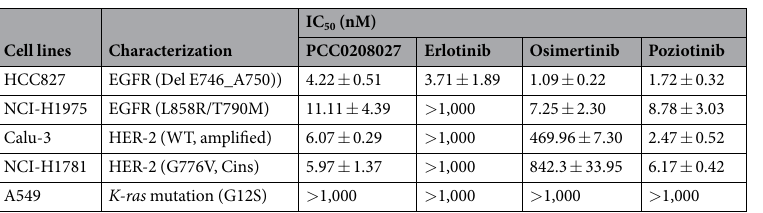
Table 2. Effect of PCC0208027 on NSCLC cell viability. Values are presented as mean ± s.d. (n =